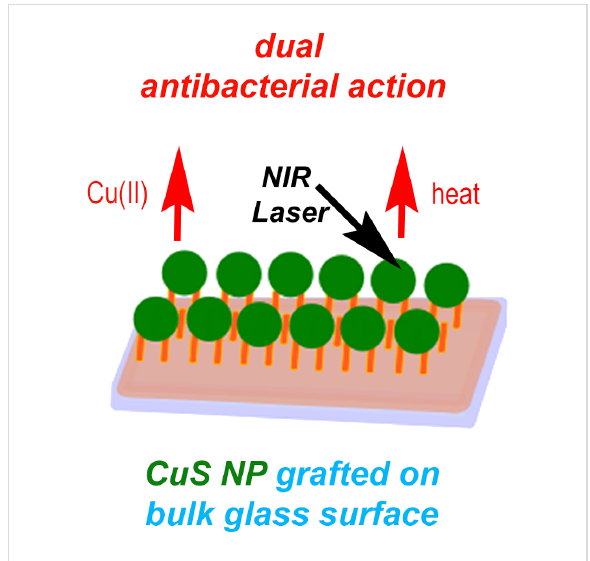
Figure 6: Dual antibacterial action of CuS nanoparticle monolayers on glass. Figure reprinted with permission from [85], copyright